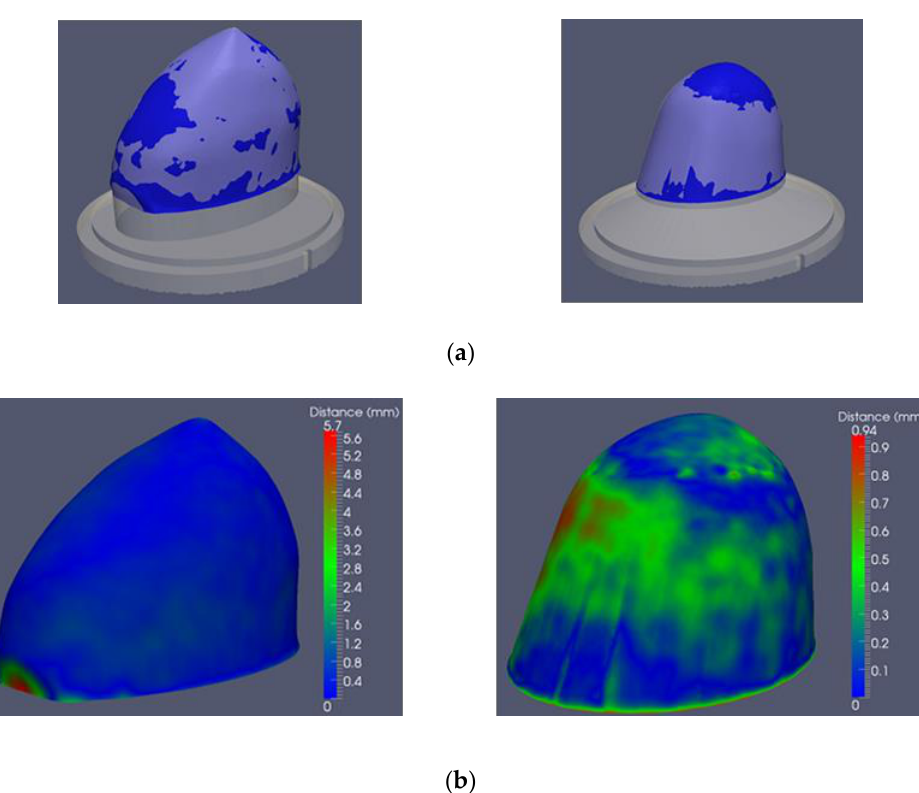
Figure 31. Breast phantom rigid registration: ( a ) example of results of the rigid registration of B1 and B2 reconstructed breast surfaces with the corresponding breast reference models; ( b ) example of breast distance color maps for the B1 and B2 extracted breast surfaces.